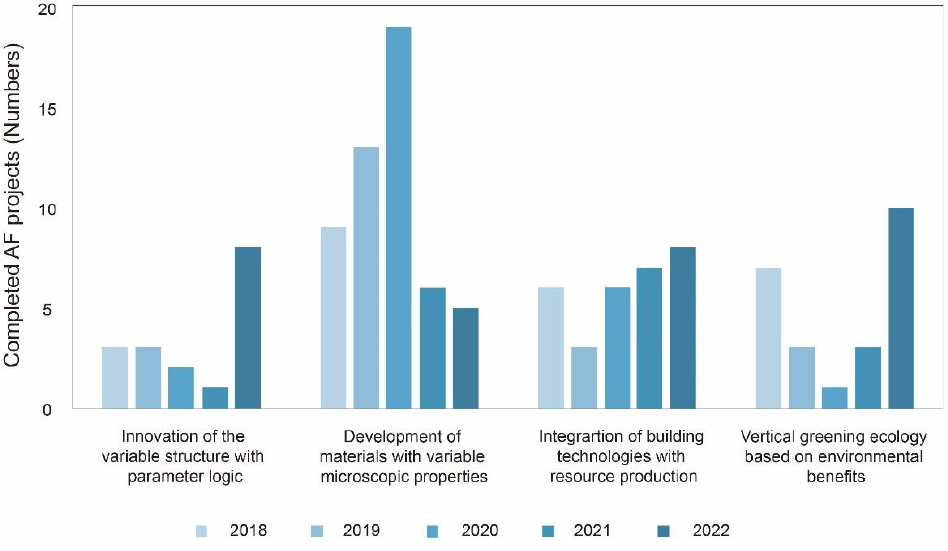
Figure 3. Practical AF